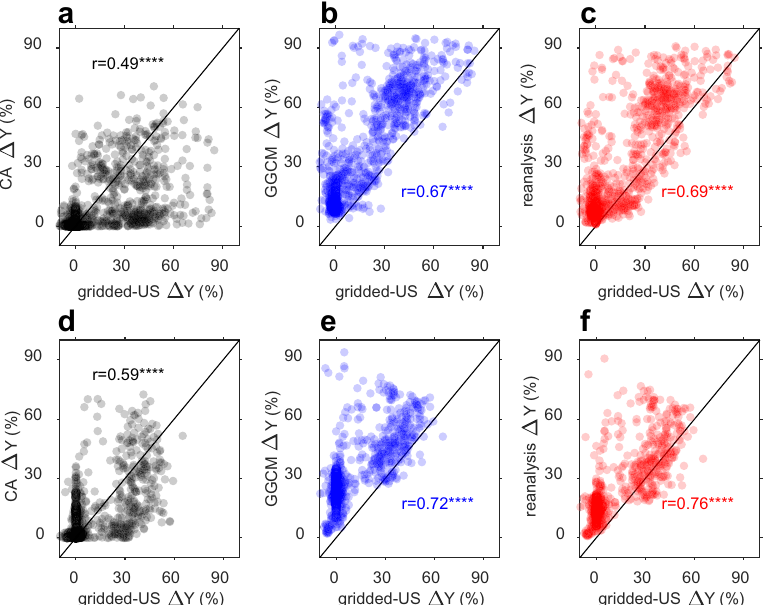
Fig. 1 Comparison of irrigation contribution to yield ( Δ Y ) estimated from statistics over conterminous United States (gridded-US) and from different approaches, for wheat (top panels) and for maize (bottom panels). a , d Δ Y estimated from the climate analogue (CA) approach; b , e Δ Y estimated from global gridded crop models (GGCM); c , f Δ Y estimated from Bayesian model average (BMA). Details of different datasets and approaches can be found in the Methods section. r indicates Pearson correlation coef fi cient between Δ Y estimated from gridded-US and other Δ Y estimates. **** indicates signi fi cant ( p < 0.01) Pearson correlation (two-tailed tests, no